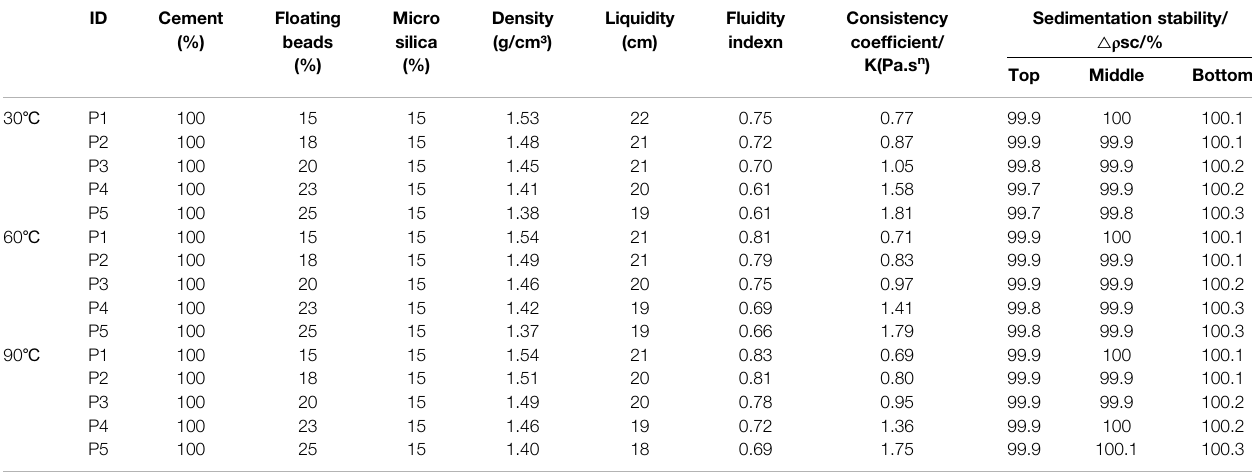
TABLE 3 | Basic engineering performance of the cement slurry mixed with fl oating beads (mass fraction